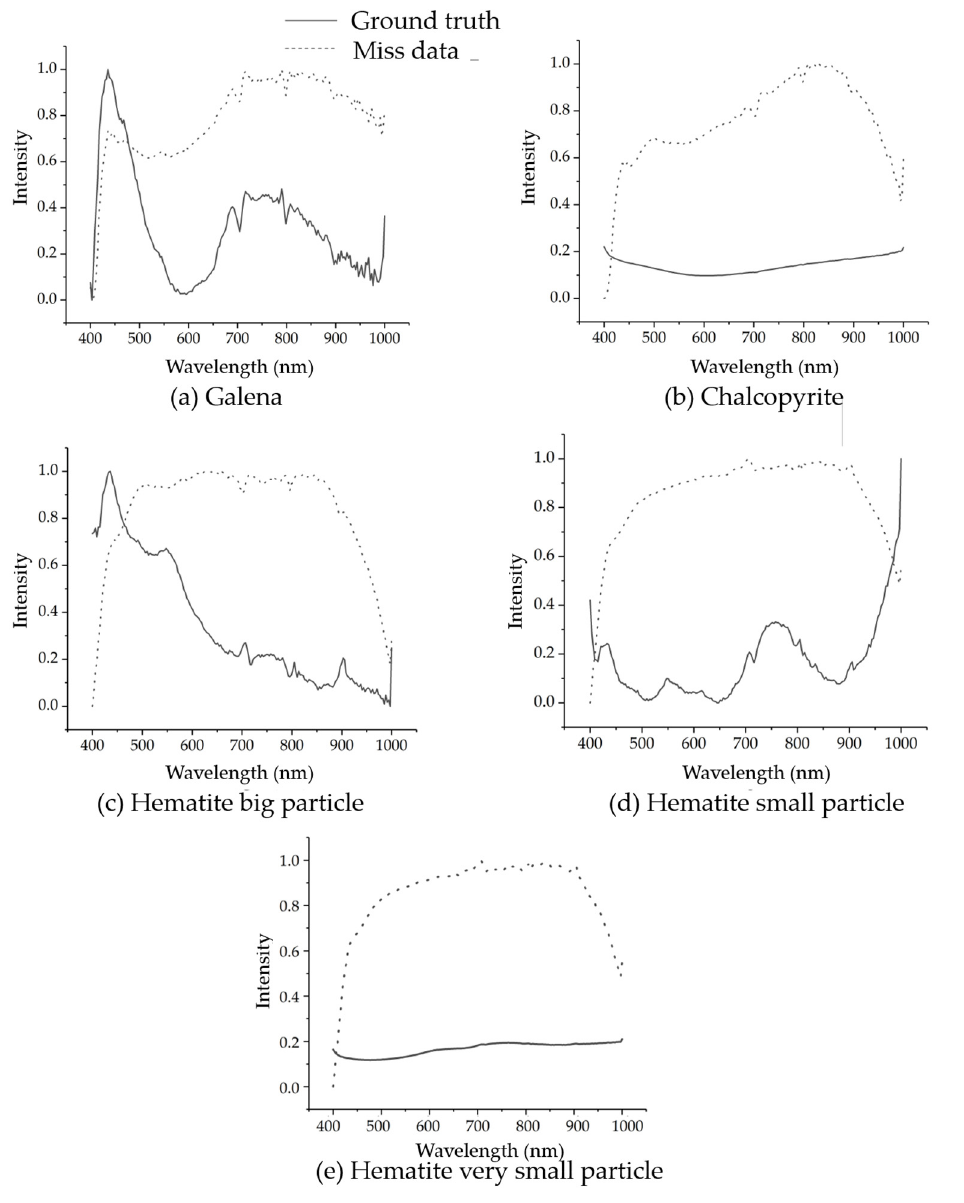
Figure 18. Comparison between the ground truth spectrum and misclassified spectrum of ( a ) galena, ( b ) chalcopyrite, ( c ) hematite large particles, ( d ) hematite small particles, and ( e ) hematite very small particles. The solid line shows the ground true spectrum and the broken line shows.